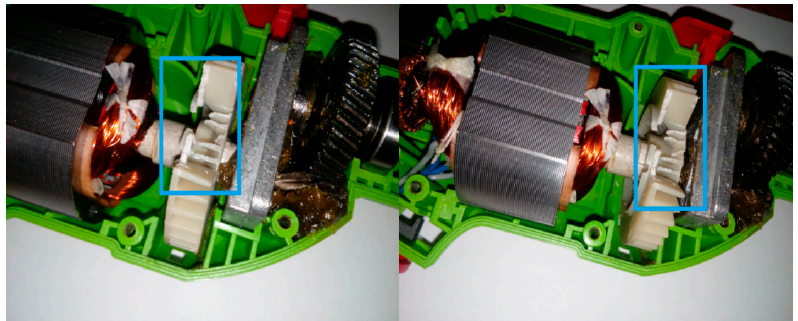
Figure 3. Healthy electric impact drill next to smartphone (by A. Głowacz under CC BY 4.0, source: [15]).